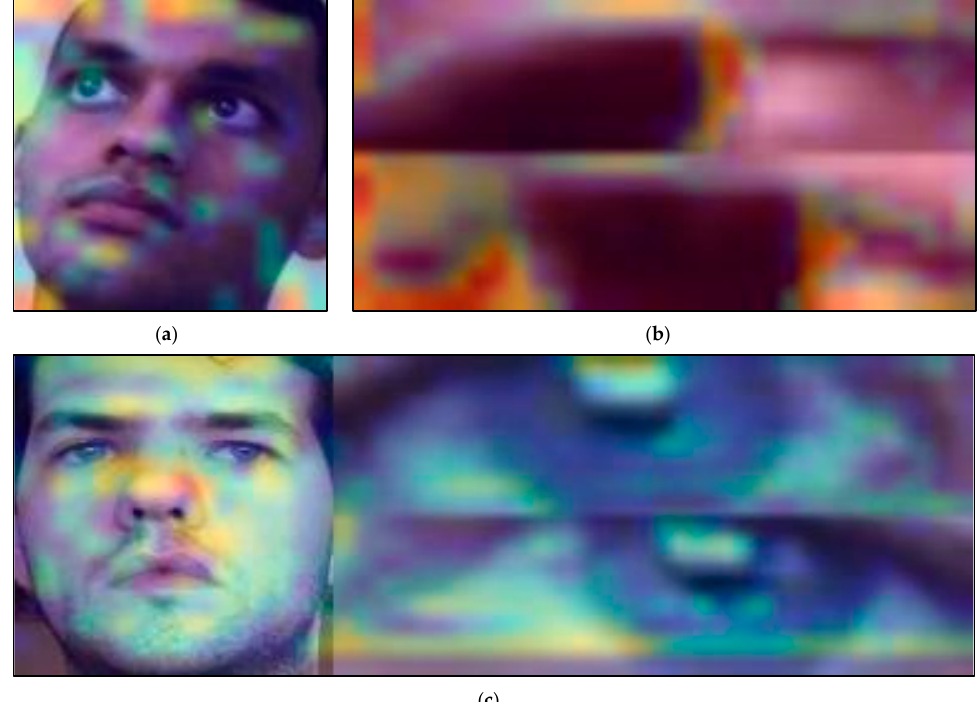
Figure 8. The Grad-CAMs of the three models: ( a ) face model, ( b ) eye model, and ( c ) fusion model. (The ID numbers of the participants are 23, 10, and 2 in the UTA-RLDD. The participants claim to allow their images to be published in research papers.)